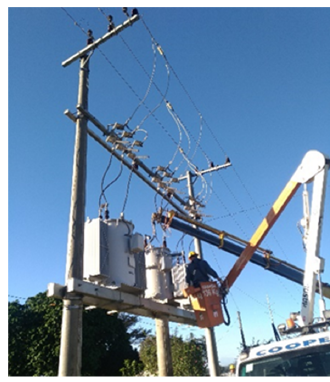
Figure 5. Voltage regulator being installed in the COOPERA company network, after removal for maintenance.